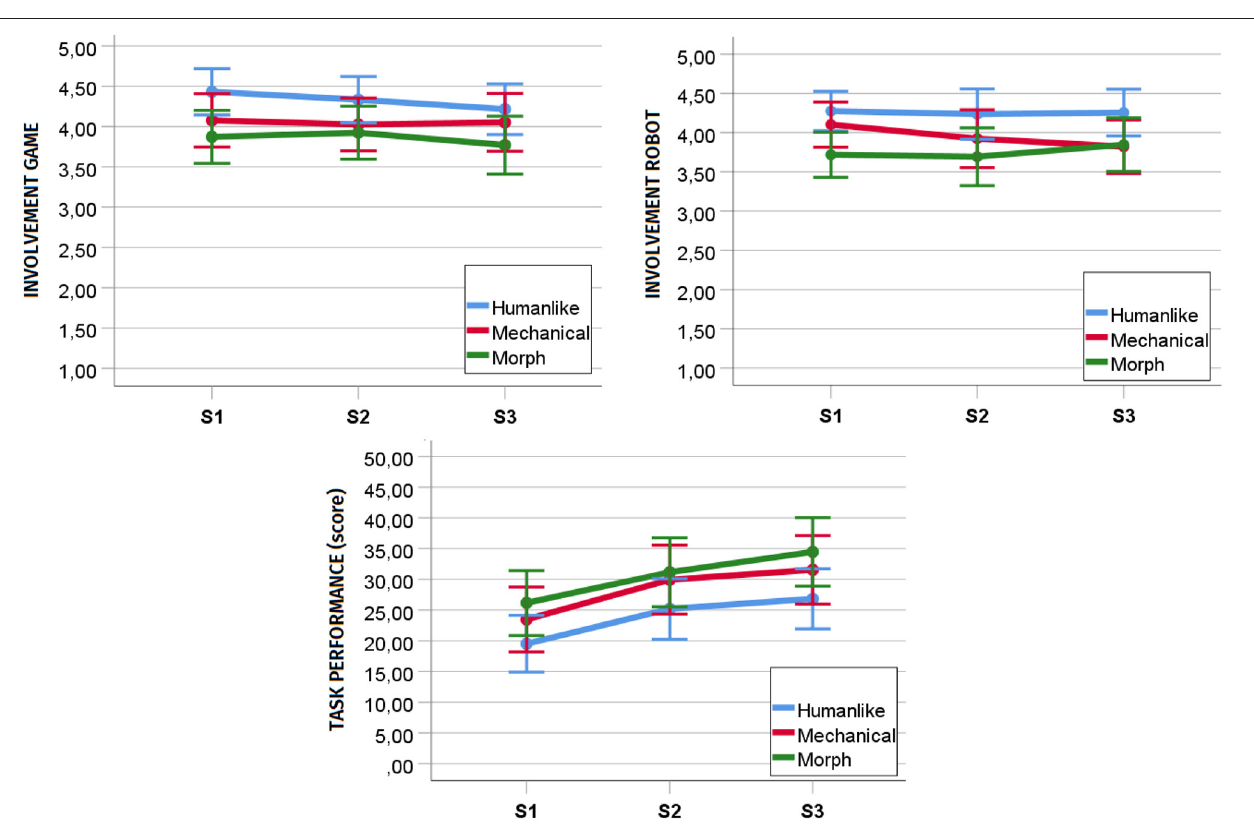
percentage of gaze directed toward the robot, toward the screen, and toward the tablet during the game interaction as predictors and involvement with the robot and with the game, and task performance as dependent